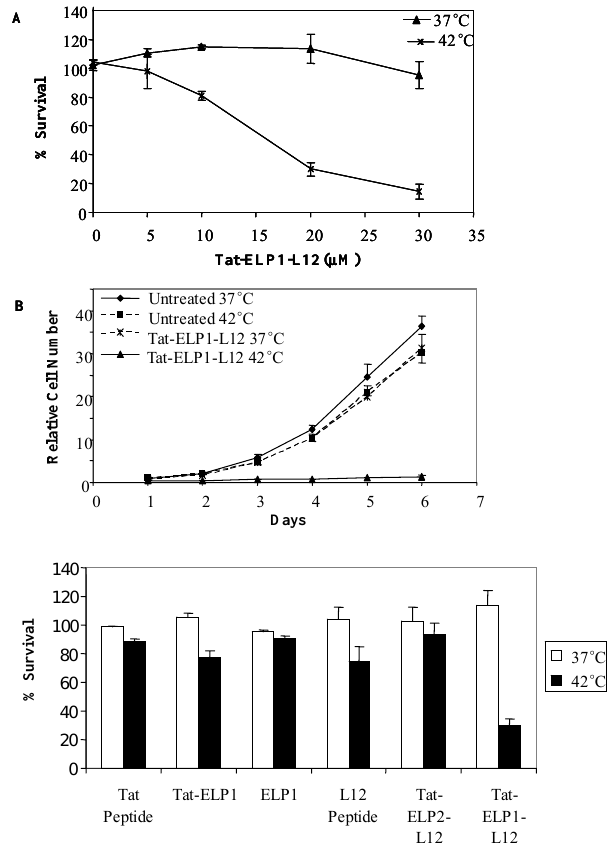
Figure 2. Temperature dependent effect of polypeptides on Mia-Paca-2 cells.